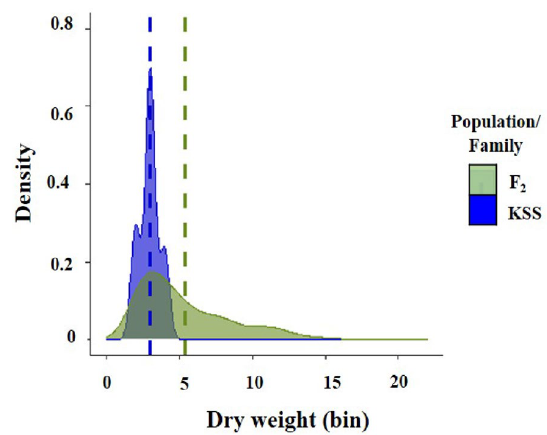
Figure 3. Cumulative dry weight data distribution of 2,4-D susceptible (KSS; n = 21) and F 2 progenies (n = 332) in response to 2,4-D at 560 g ae ha −1 (field recommended dose) via density plot. Dry weight of samples was converted into bins and plotted on the X-axis. Y-axis was plotted by calculating density which is the proportion of total plants in each bin. Dotted lines represent mean dry weight of 2,4-D susceptible (KSS) and F 2 plants.